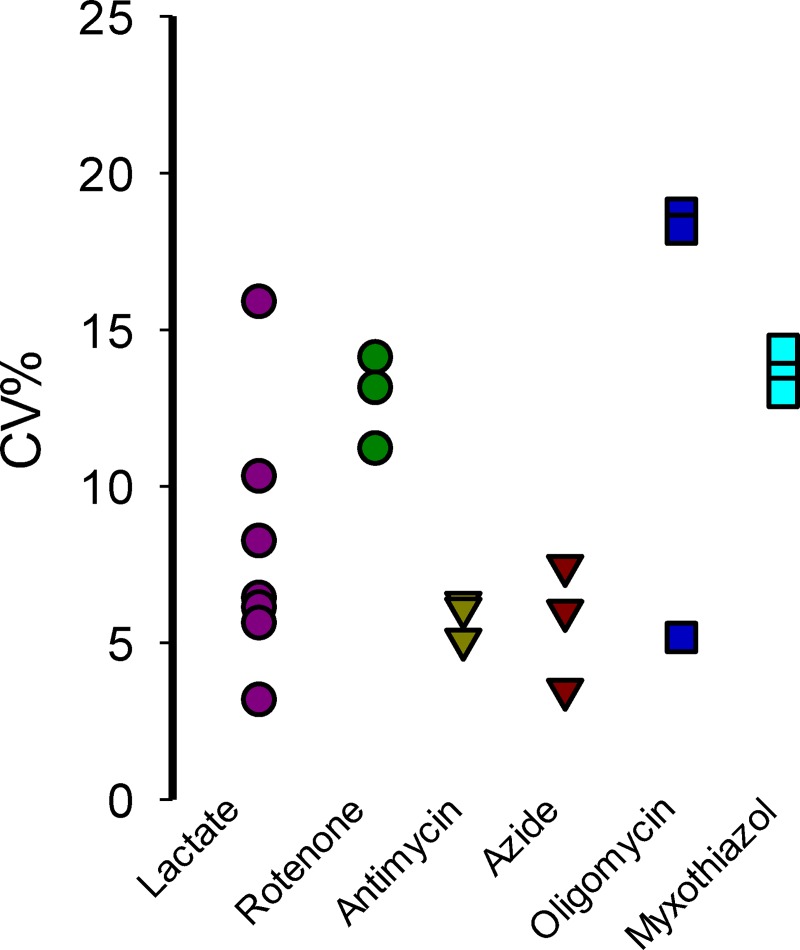
Inter and intra-well variability analysis.CV% values were calculated using the average wells from three independent plates.